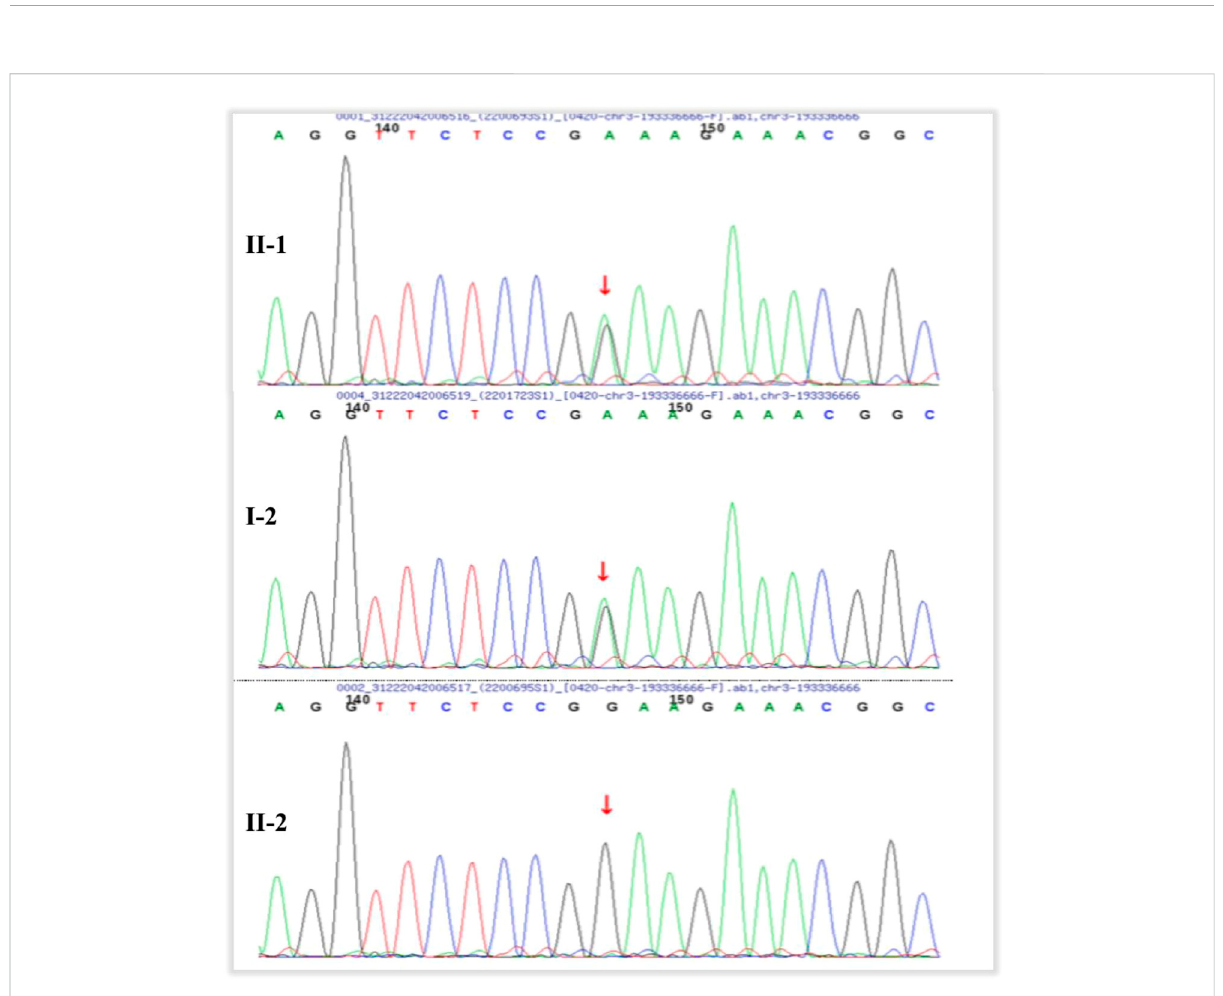
FIGURE 11 Pedigrees of the families. The proband (II – 1) and his mother (I – 2) have heterozygous mutation of OPA1 (c.565G > A, p .Glu189Lys). The proband ’ s fraternal twin brother (II – 2) has no